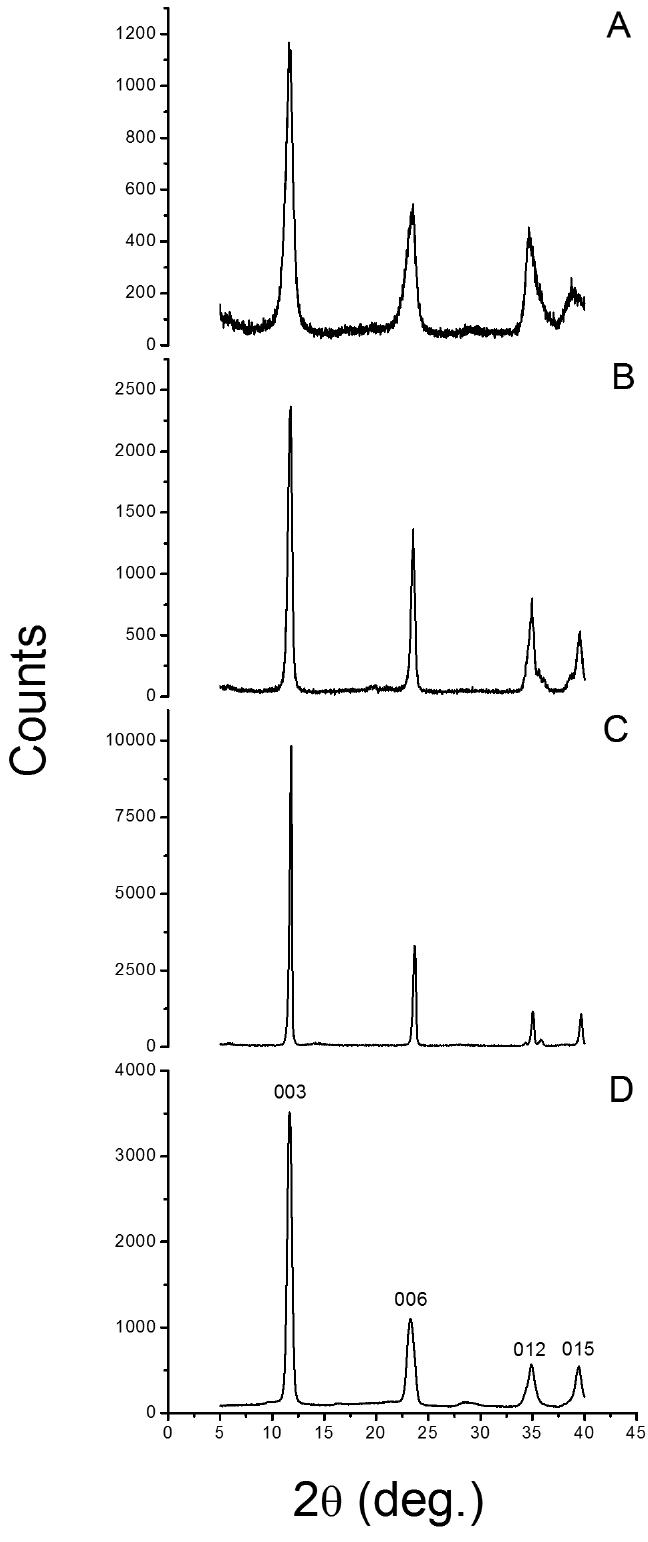
Figure 2. The XRD signals for different LDH particles are presented. ( A ) LDH-OH; ( B ) LDH-C; ( C ) LDH-U and ( D ) commercial HT